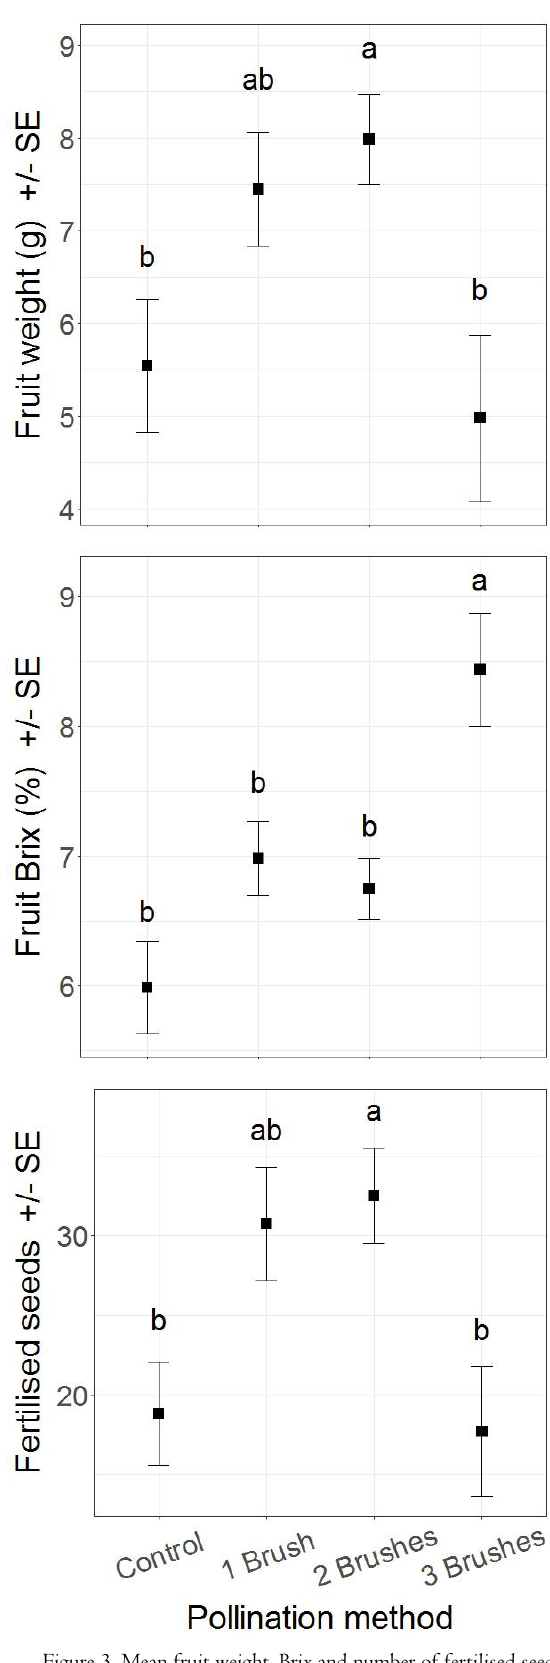
Figure 3. Mean fruit weight, Brix and number of fertilised seeds per fruit half by pollination method. Boxes indicate least square means ± standard error. Means sharing the same letter are not significantly different (Tukey-adjusted